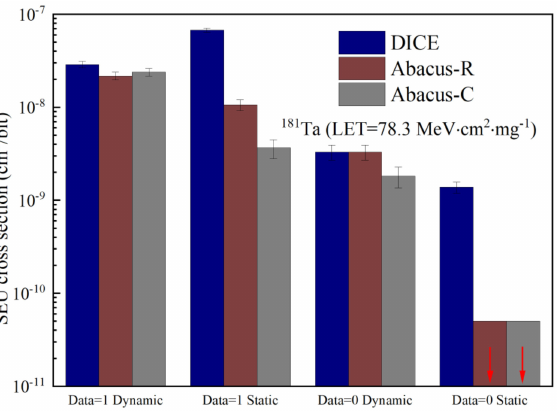
Figure 8. SEU cross section results for different data patterns and test modes.